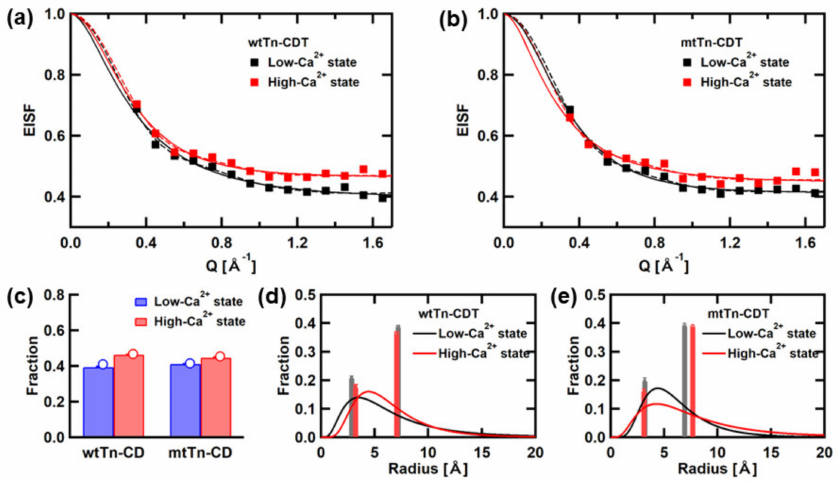
Figure 5. Summary of the EISF curves and their analysis using Equation (6). ( a , b ) The EISF curves of the wtTn-CD and the mtTn-CD, respectively. Solid lines are the results of the analysis using Equation (6). Dashed lines are the results of the analysis based on the diffusion-inside-a-sphere model with two spheres of distinct radii employed in the previous study [13]. ( c ) Summary of the fraction of the “immobile” atoms. Bars represent the results of the analysis using Equation (6). Open circles represent the results of the analysis based on the diffusion-inside-a-sphere model with two spheres of distinct radii (Equation (7)). ( d , e ) The radial distribution of the fraction of the “mobile” atoms in the wtTn-CD, and the mtTn-CD, respectively. Solid lines represent the results using Equation (6). Bars represent the results of the analysis using Equation (7).